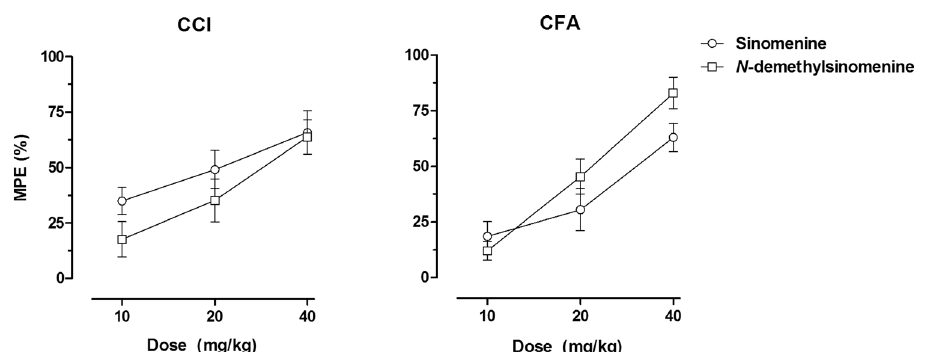
Figure 2. Dose–effect curves of sinomenine and N -demethylsinomenine in CCI-operated (left) and CFA- treated (right) mice. Data were expressed as percentage of maximal possible effect (% MPE) (mean ± S.E.M., n = 9–10 per group) and plotted as a function of drug dose; 100% MPE represented data from the normal baseline mechanical PWT before CCI surgery of CFA